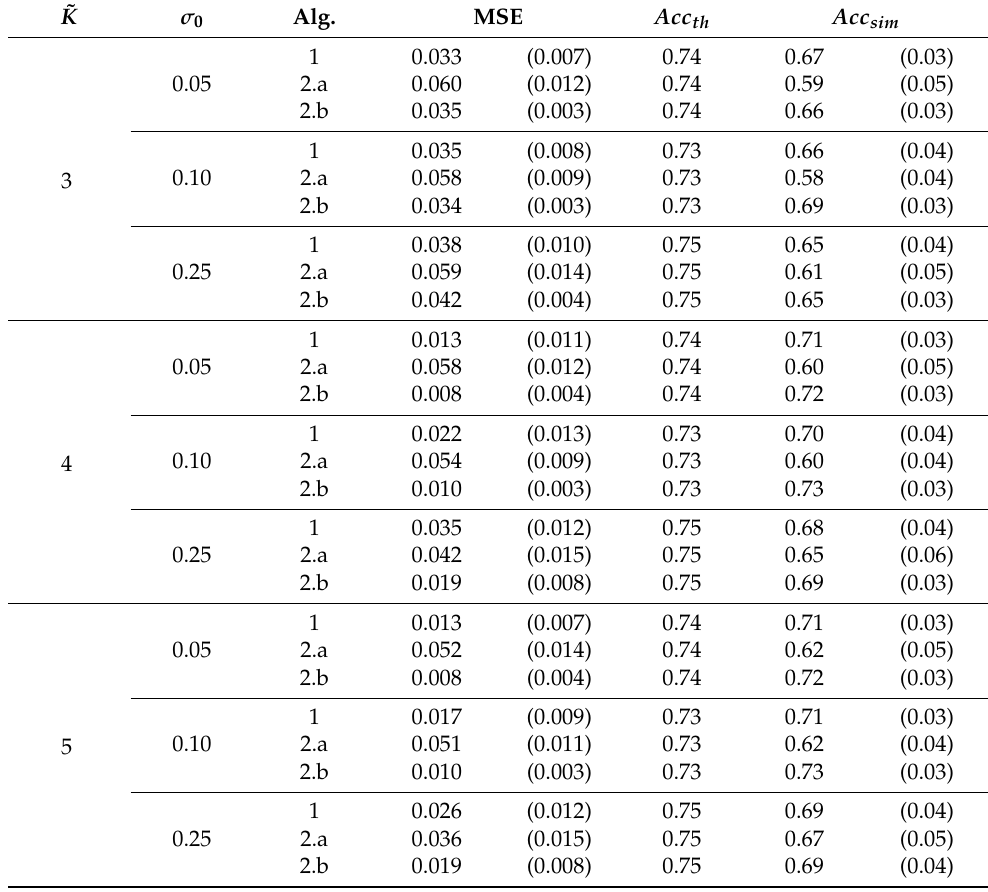
MSE ( P ) r and accuracy (standard deviation in Table 2. Mean values of MSE ( P ) = ( 1/400 ) ∑ 400 r = 1 brackets) for a different number of critical points. Acc th makes reference to the accuracy obtained by using the true model, while Acc sim represents the accuracy values obtained from the